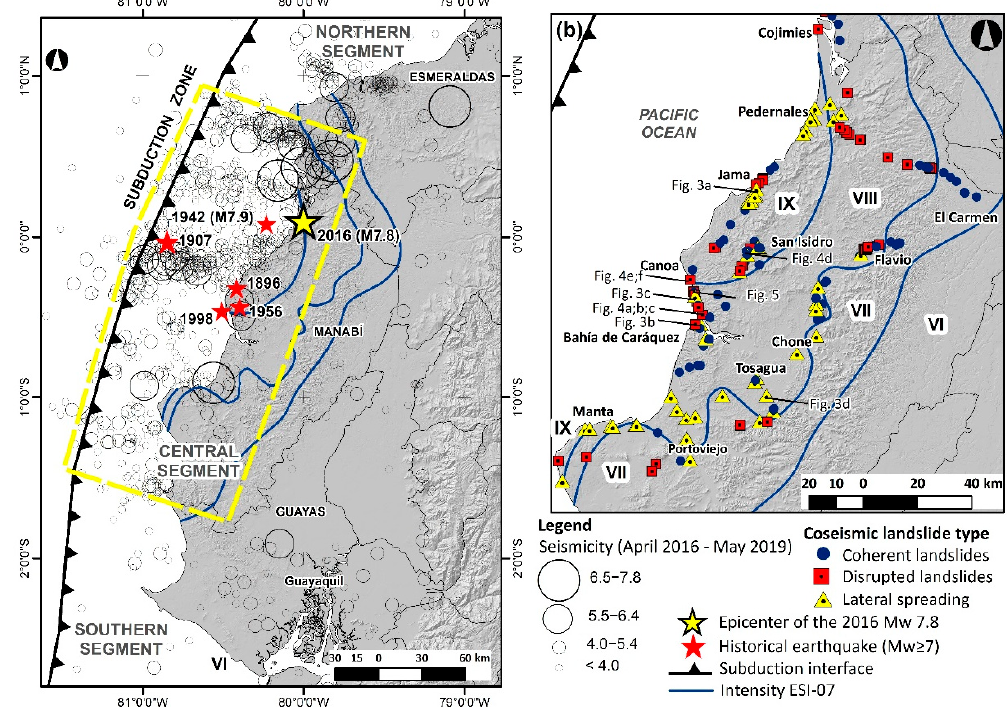
Figure 2. Location maps and seismotectonic setting: a ) regional view of central tectonic segment of Ecuador coastal region (yellow dashed box): the epicenters of large subduction events occurred offshore the Manabí province (red stars) and the spatial distribution of aftershocks from the 16th April 2016 to 30th May 2019 are reported; b ) earthquake-triggered landslides accompanying the 2016 Pedernales earthquake, dots mark the types of coseismic landslides and blue lines mark the ESI-07 isoseismals as defined by [22]; the location of the photographic documentation in Figures 3 and 4 is also reported.